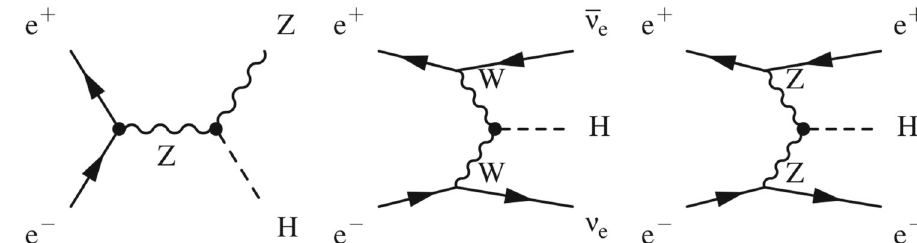
Fig. 1 Feynman diagrams for the three dominant Higgs boson production modes: e + e − → H Z